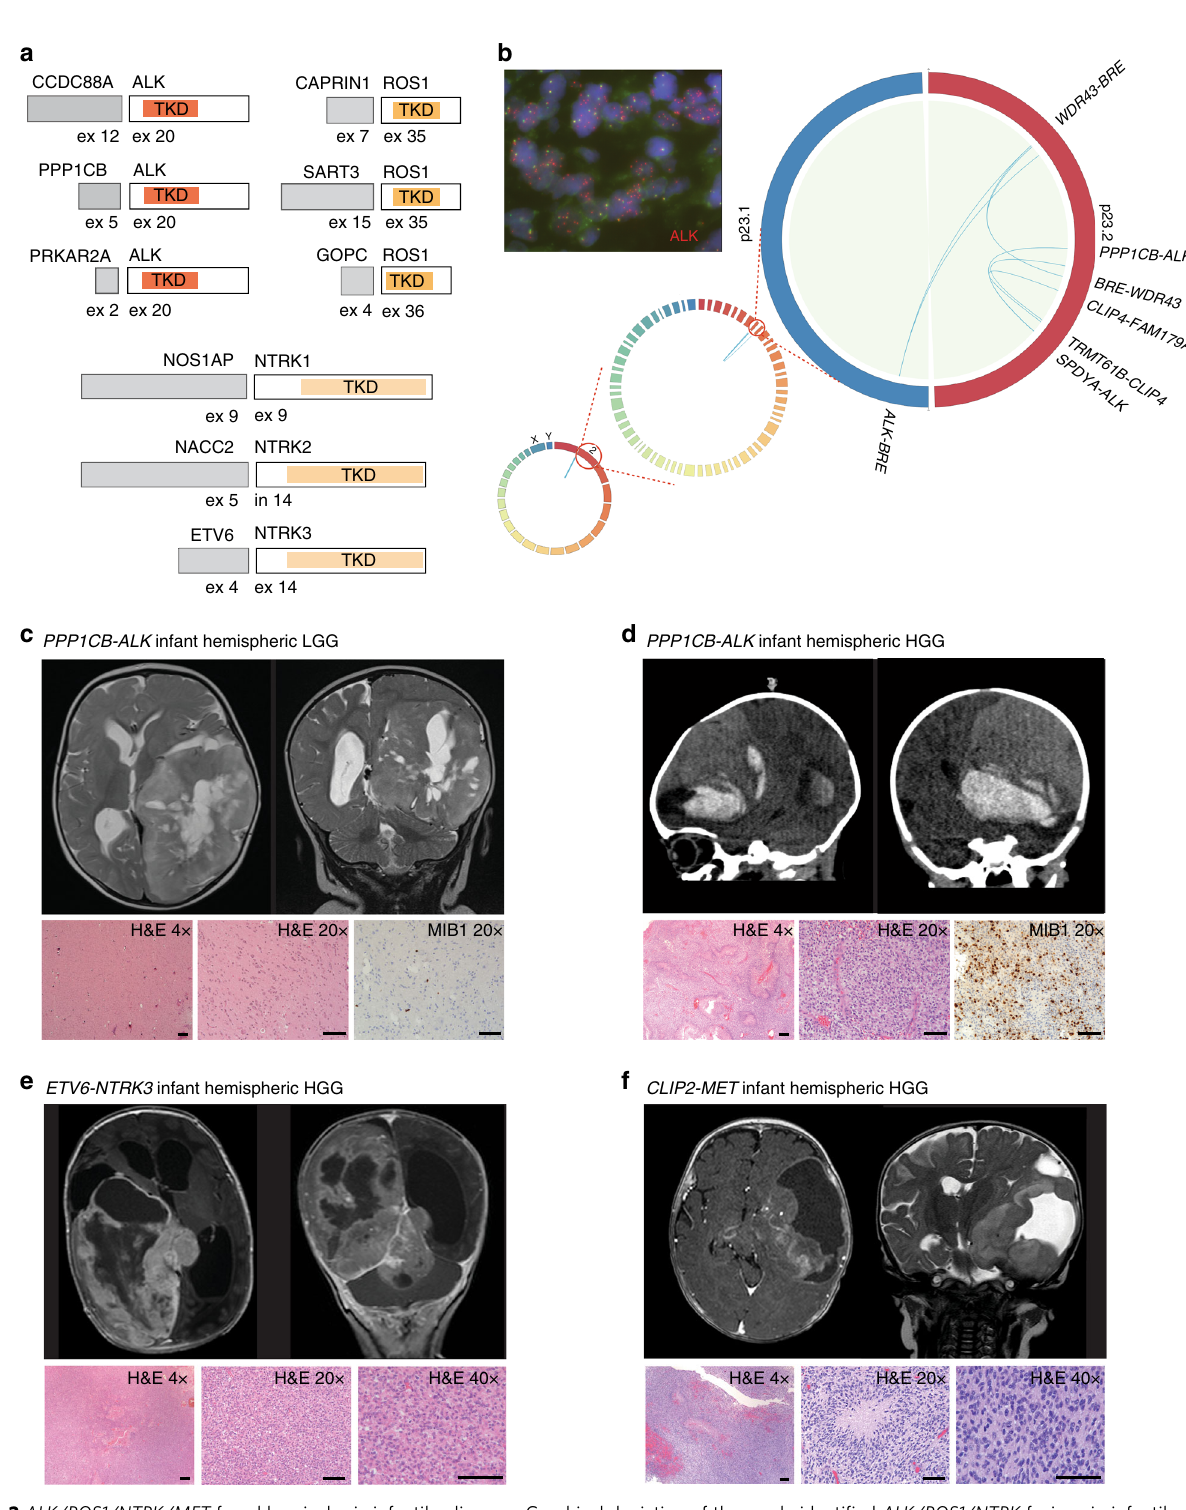
Fig. 2 ALK/ROS1/NTRK/MET fused hemispheric infantile glioma. a Graphical depiction of the newly identi fi ed ALK/ROS1/NTRK fusions in infantile glioma. b Circos plot depicting the chromothripsis events with > 10 split-read support from total RNAseq of a PPP1CB-ALK tumor with progressive scaling from full chromosome set to chr 2 p23.1-p23.2 arms. FISH for ALK further showing evidence of ALK translocation and ampli fi cation in a tumor positive for PPP1CB- ALK . c , d Examples of PPP1CB - ALK positive tumors — an iLGG diagnosed at 10 months of age ( c ) and a congenital iHGG ( d ) — including imaging (MRI axial and coronal T2-weighted images, c ; sagittal and coronal head CT, d ), hematoxylin and eosin (H&E) staining, and proliferation index (MIB-1). Further examples of large hemispheric congenital iHGG harboring RTK fusions with ETV6-NTRK3 ( e ) and CLIP2-MET ( f ). All images are taken at the stated magni fi cation, scale bar = 100 μ m for x20 and x40, 200 μ m for ×4. TKD: tyrosine kinase domain, LGG: low-grade glioma, HGG: high-grade glioma, H&E: Hematoxylin and eosin